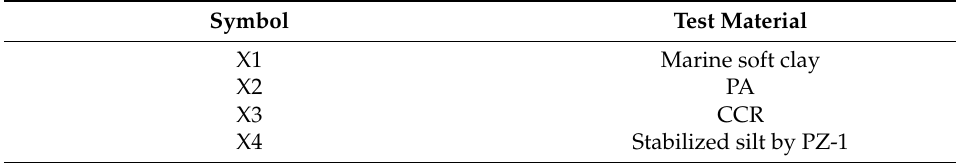
Table 4. Experimental design of XRD.